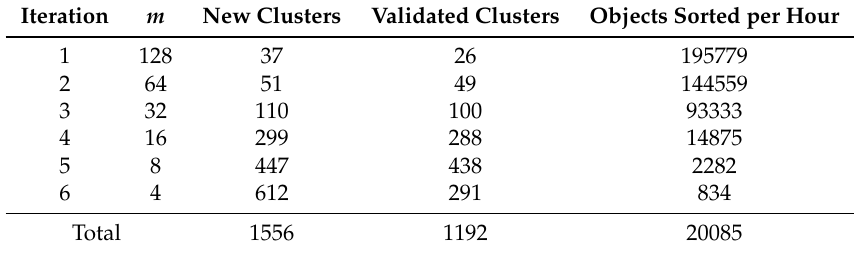
Figure 5. Number of validated objects during data annotation. The time periods are colored according to their respective phase. Table 2. Iterations in the MorphoCluster process with metrics in each step. Minimum cluster size m ; number of proposed new clusters; number of validated clusters; number of objects sorted per hour. Note that, at this point, the raw clusters have not been grouped and named